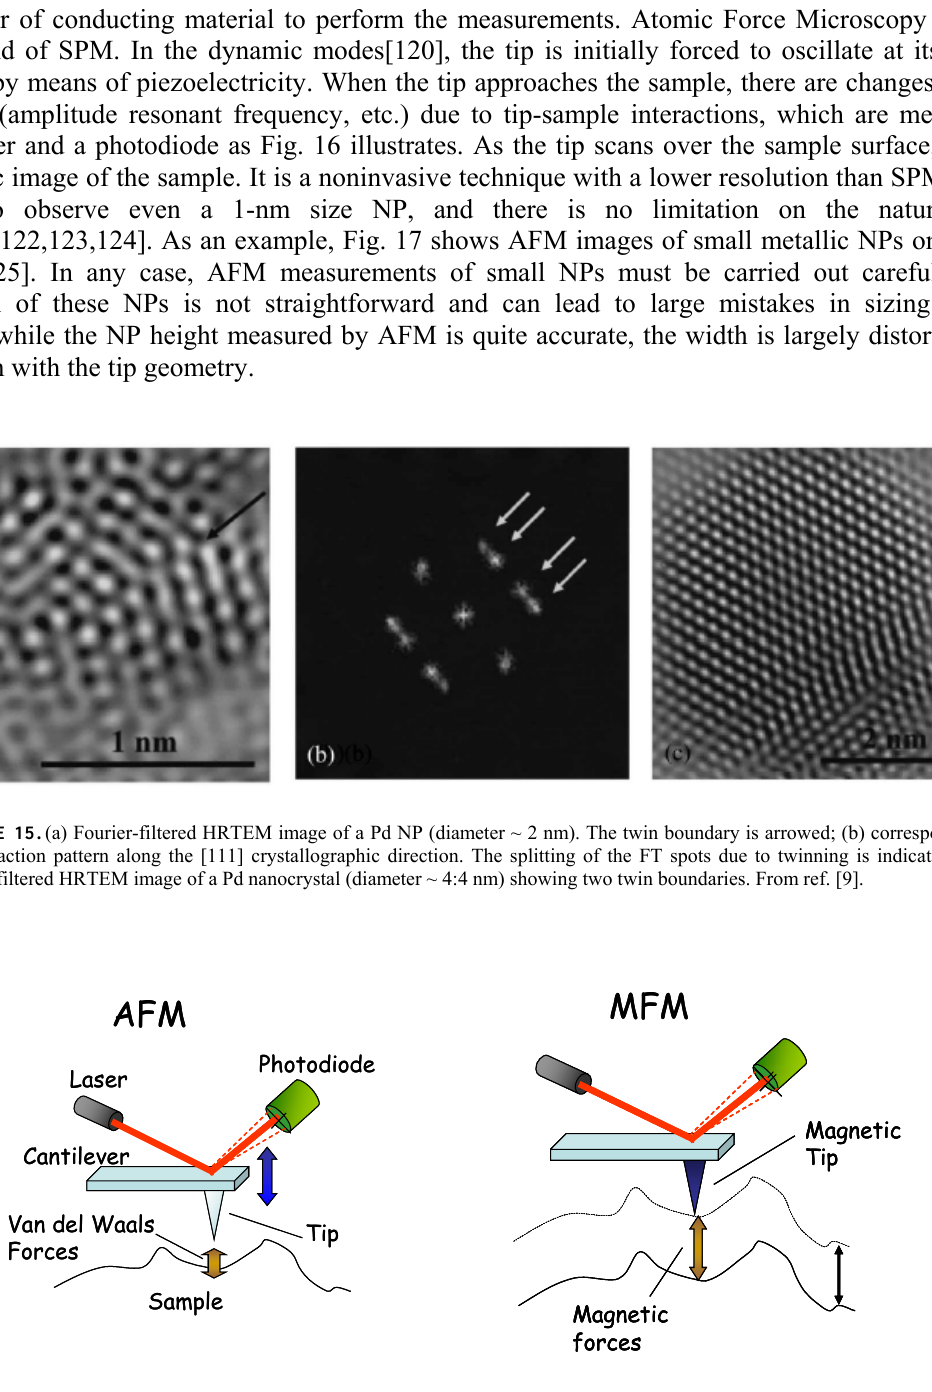
FIGURE 16 . Scheme of AFM (left) and MFM (right) measurements